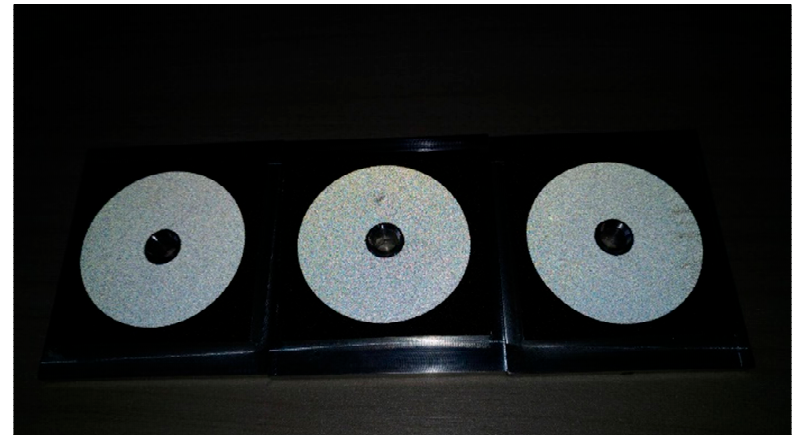
Figure 3. Circular targets whose center coordinates were measured with both LT, inserting the prism into the central housing, and photogrammetric systems DPA (AICON MoveInspect DPA system with a Nikon D3x metric camera) and CRP (Close-Range Photogrammetry).